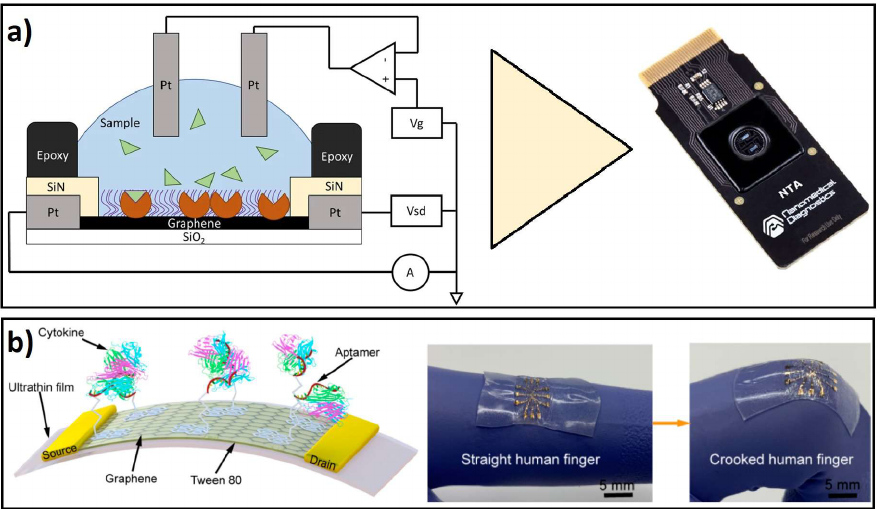
Figure 4. Wearable-remote-portable biosensors. ( a ) Design, manufacture, and parts of a FEB biosensor and its integration into a compact biosensor. ( b ) Design and manufacture of a flexible FET support for skin biosensor. Source: Figure adapted from ( a ) [224] and ( b ) [129] with permission of Springer and